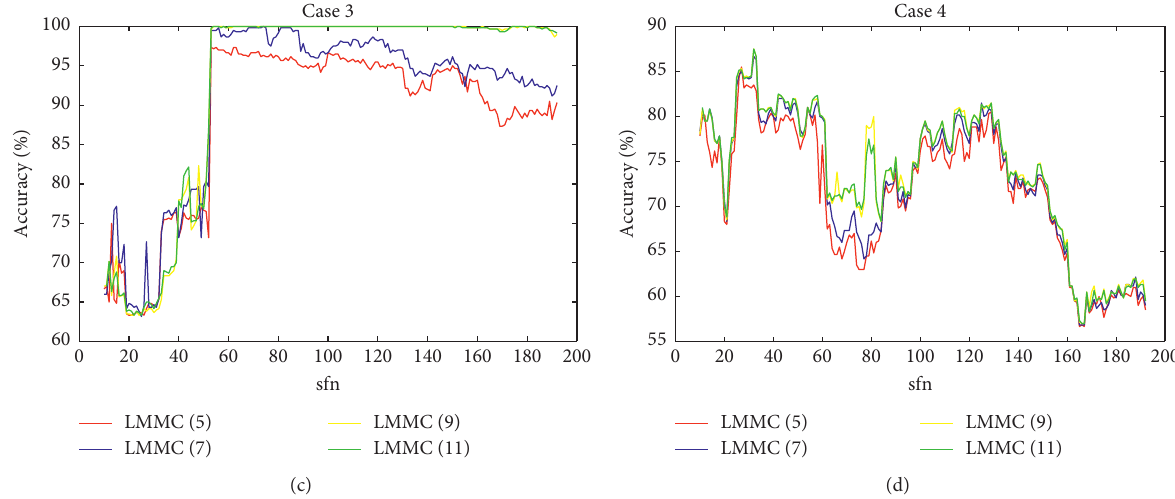
Figure 25: The diagnosis results obtained by OFS-TSFRS-LMMC-SVM with different number of dimension sizes for LMMC. The LMMC (5) represents that the number of dimension size is